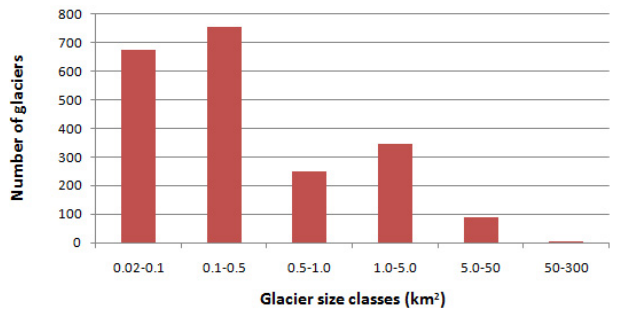
Fig. 3. Diagram showing the glacier size class vs. number of glaciers in upper Shyok